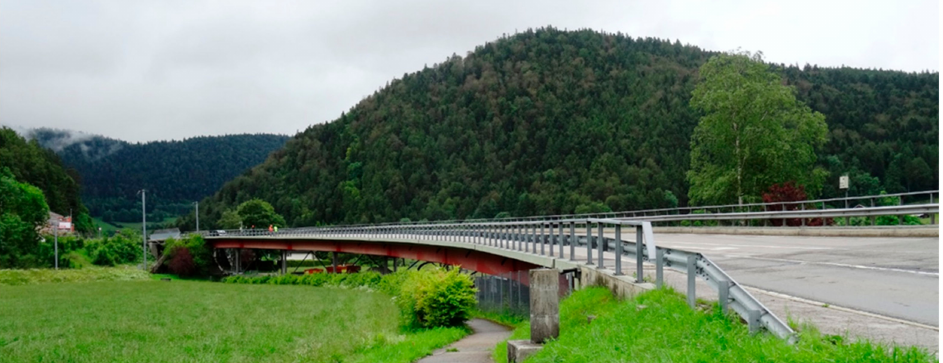
Figure 7. A view of Cr ê t De